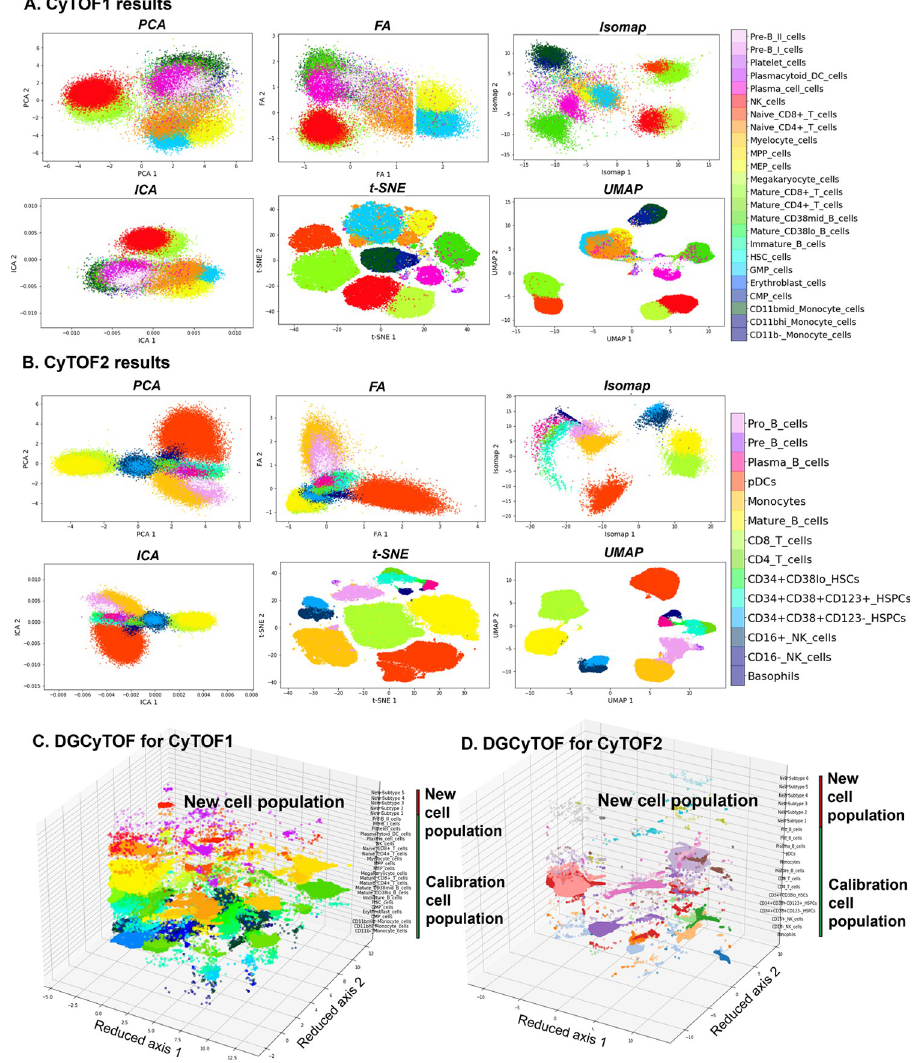
Fig 4. Visualizations of cell populations in databases CyTOF1 and CyTOF2. ( A-B ) Two-dimensional visualization of embedding of cells for the identification of dimension-reduction techniques in databases CyTOF1 ( A ) and CyTOF2 ( B ). Cell subtypes are labeled by DGCyTOF for databases CyTOF1 ( C ) and CyTOF2 ( D